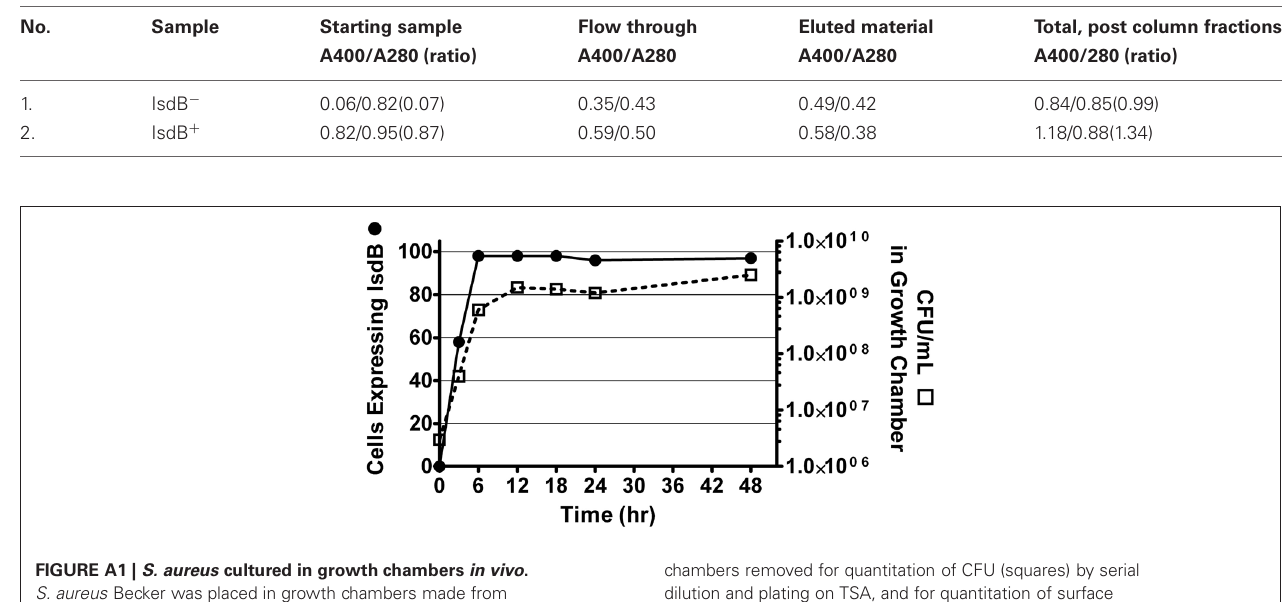
chambers removed for quantitation of CFU (squares) by serial dilution and plating on TSA, and for quantitation of surface expression of IsdB (circles) by flow cytometry (% of cells positive for